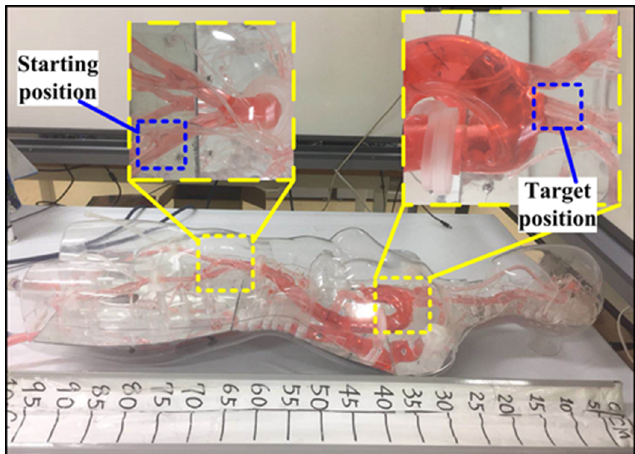
Figure 17. The EVE model for the evaluation experiment.